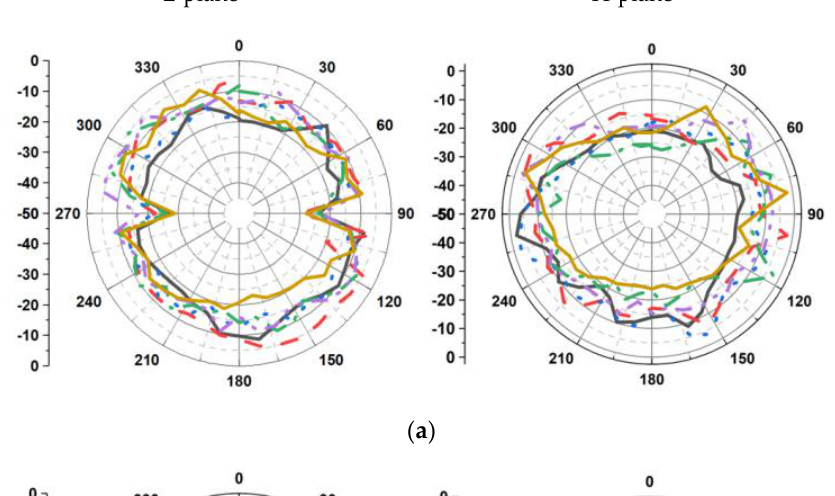
Figure 12. Measured radiation patterns of the antenna: ( a ) when port 1 is excited, ( b ) when port 2 is excited.